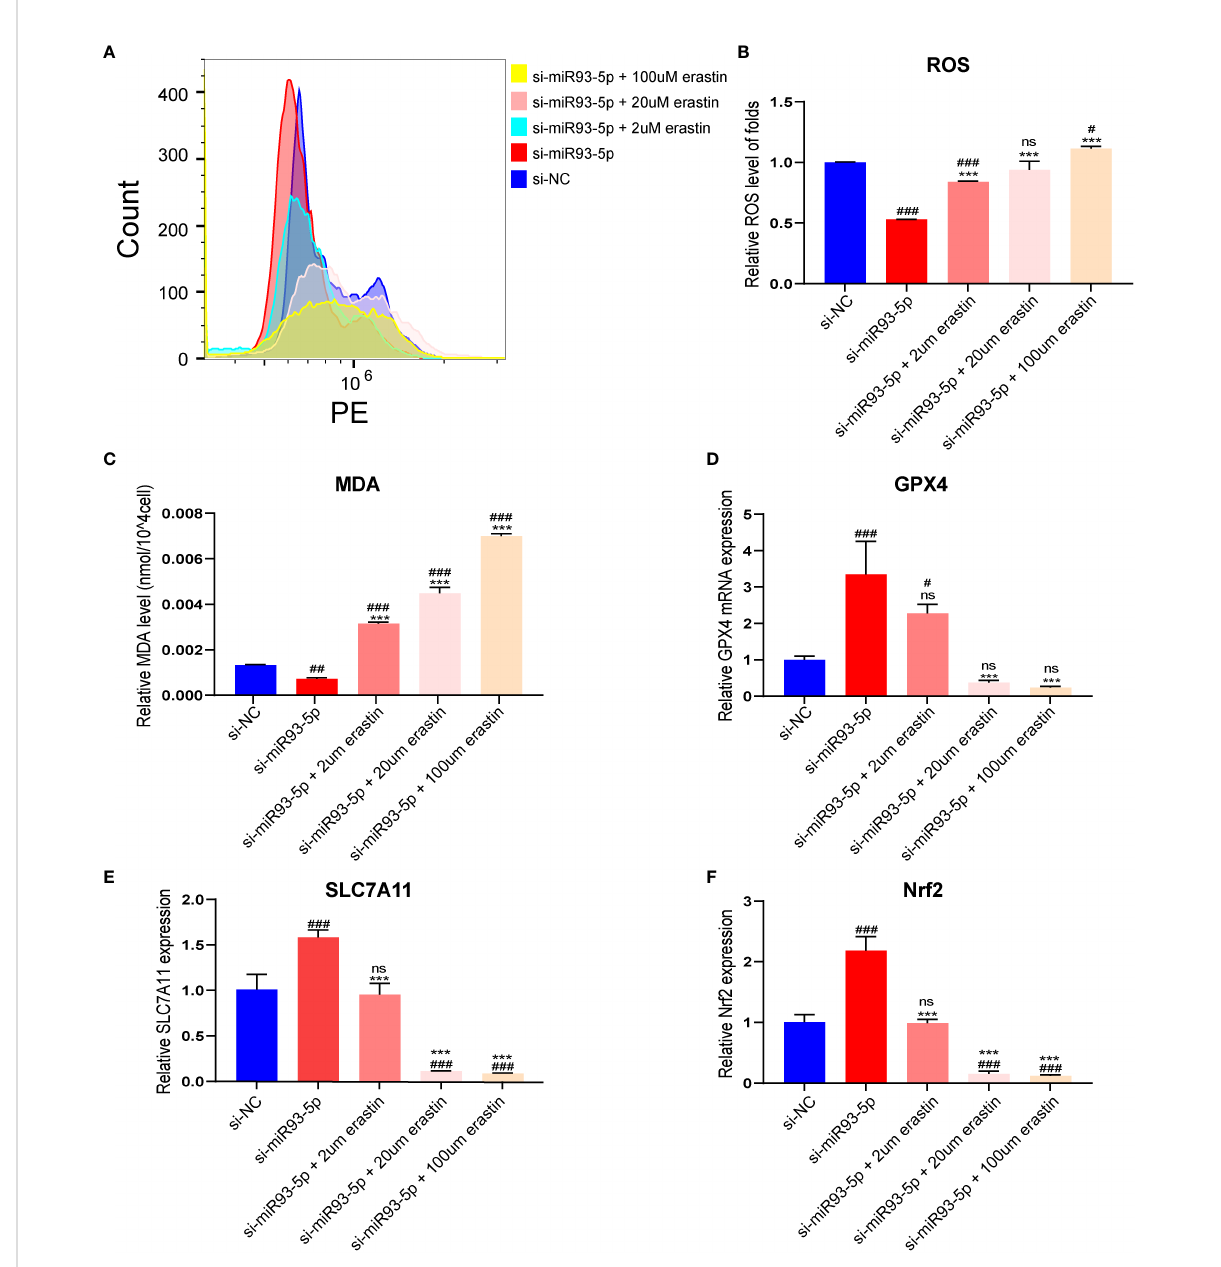
FIGURE 5 The effect of inhibition of miR-93-5p on the ferroptosis in GC. (A, B) The ROS level between the si-NC, si-miR93-5p and treated with erastin (2, 20, and 100 m M) groups. (C) MDA assay was used to detect lipid peroxidation in the presence of erastin (2, 20, and 100 m M) in the si-miR93-5p group. GPX4 (D) , SLC7A11 (E) and Nrf2 (F) mRNA expression was assessed by qRT – PCR in the presence of erastin (2, 20, and 100 m M) in the si- miR93-5p group. # p < 0.05, ## p < 0.01 and ### p < 0.001 compared with the si-NC group. *** p < 0.001 compared with the si-miR93-5p group. ns means no statistical difference. GPX4, glutathione peroxidase 4; SLC7A11, solute carrier family member 11; MDA, malondialdehyde; ROS, reactive oxygen